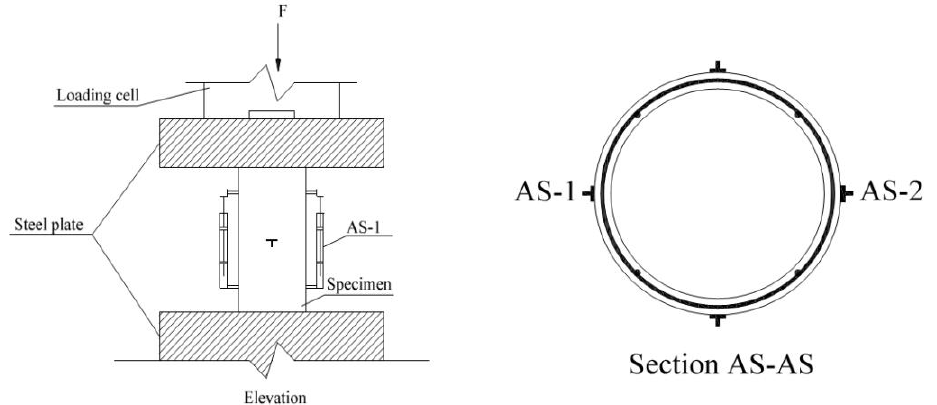
Figure 4. Test setup and instrumentation.